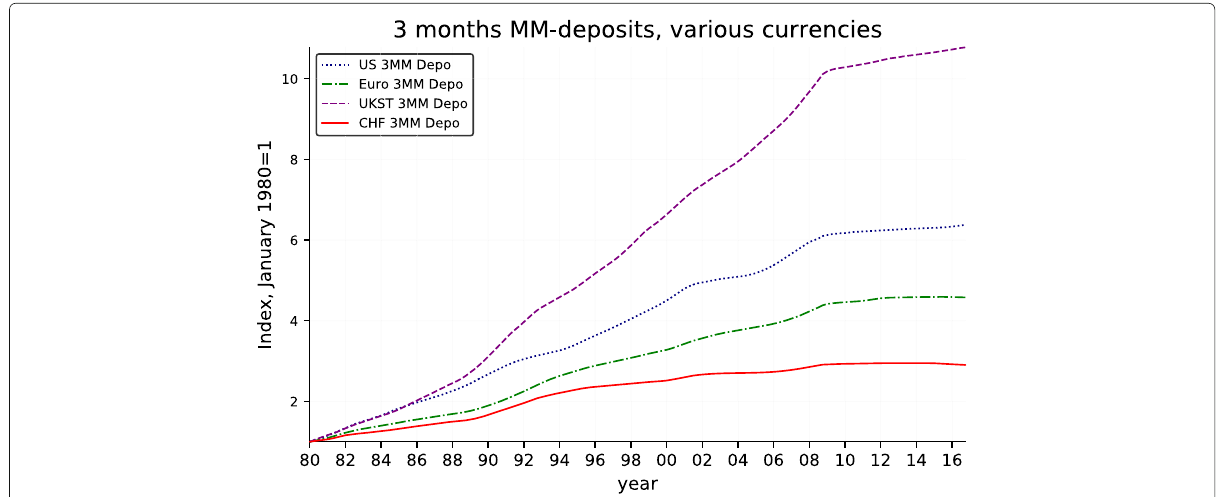
Fig. 2 Cumulative return on 3-month MM